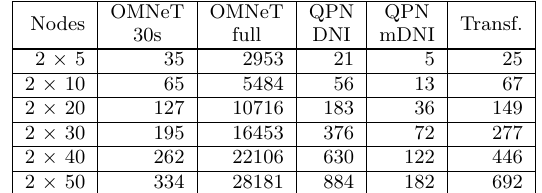
Table 4: Scenario 2 A : model solution duration (in seconds) for growing traffic intensity